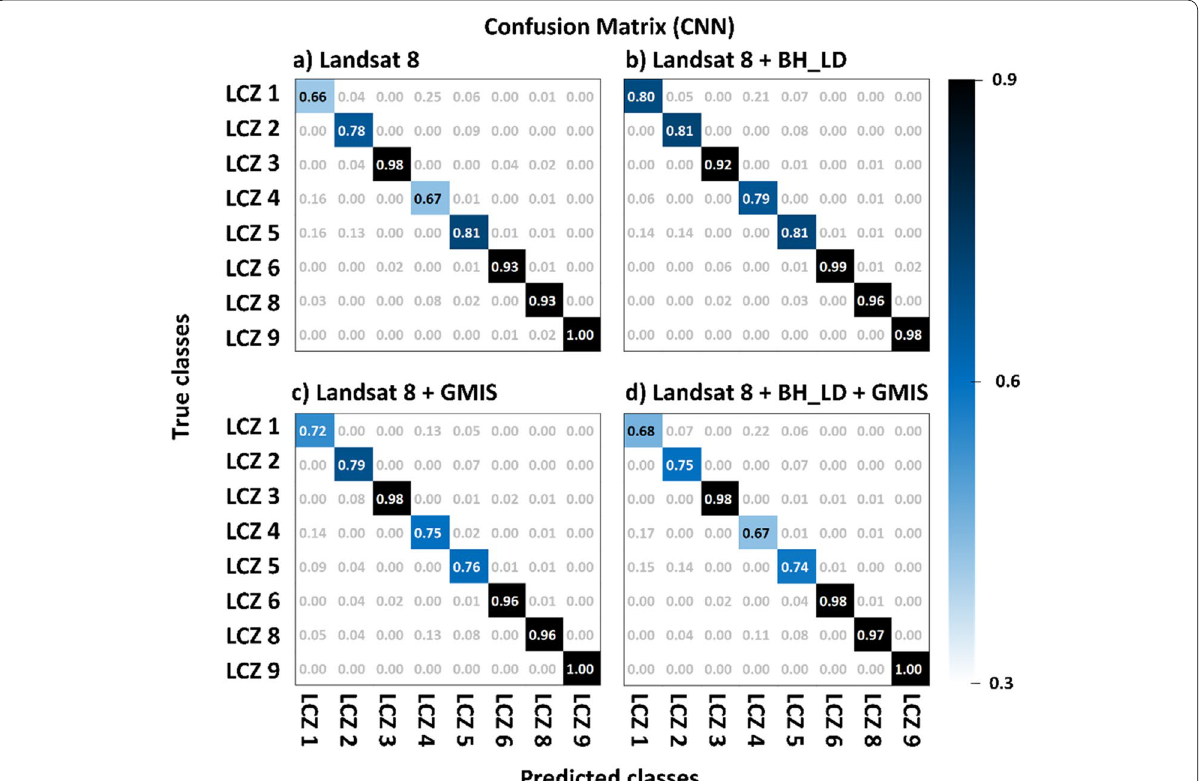
Fig. 10 The confusion matrix of the urban‑type classes from the CNN classifier using a LS8, b LS8 LD GMIS input +